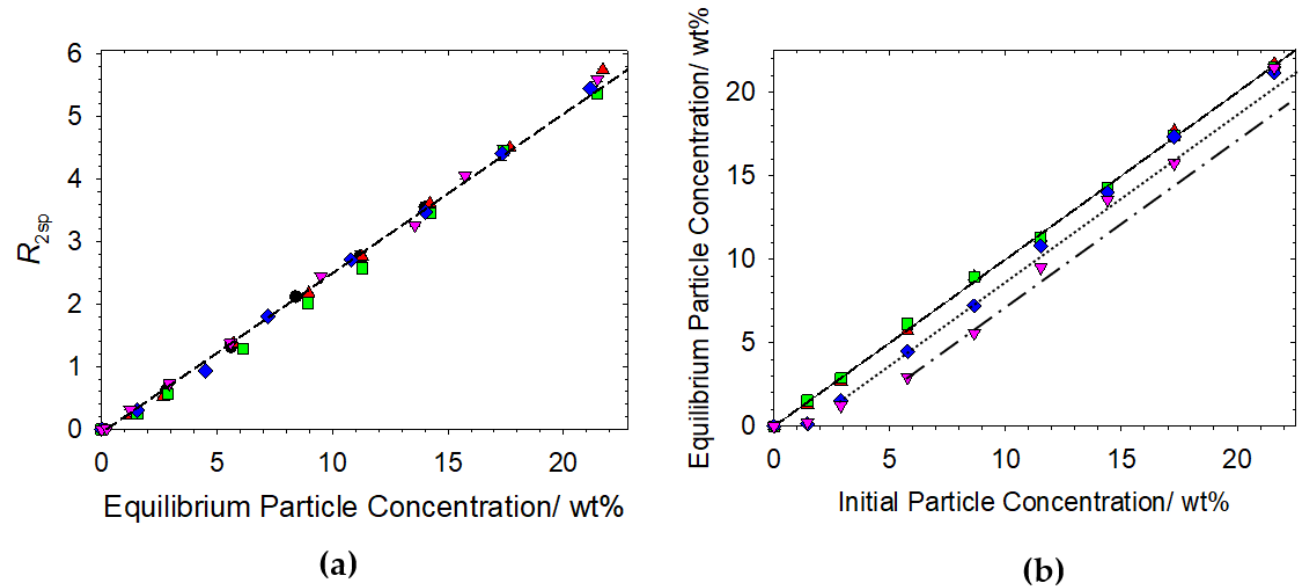
Figure 3. ( a ) Specific relaxation rates as a function of the equilibrium particle concentration for mixtures containing cat-HEC ( n = 0.95%), SDS and Ludox. Regression plot is through Ludox-only data. ( b ) Equilibrium particle concentration as a function of initial particle concentration for the mixtures. X = Y plot is included as a guide for the eye; dotted and dot dash lines are linear offsets from the X = Y plot. Symbols: ● , Ludox only; ▲ , 4 mM SDS + 0.1 wt% cat-HEC polymer (Z = 0.15); ■ , 2 mM SDS + 0.1 wt% cat-HEC polymer (Z = 0.30); ♦ , 0.5 mM SDS + 0.1 wt% cat-HEC polymer (Z = 1.20); ▼ , 0.1 wt% cat-HEC polymer.